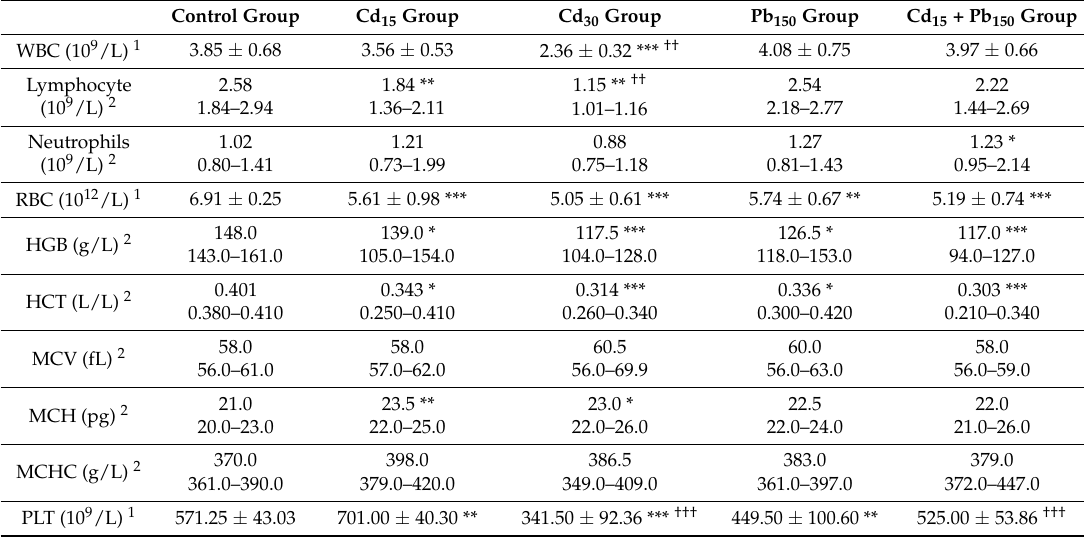
Table 1. Effect of Cd or/and Pb on hematological parameters in rats after acute